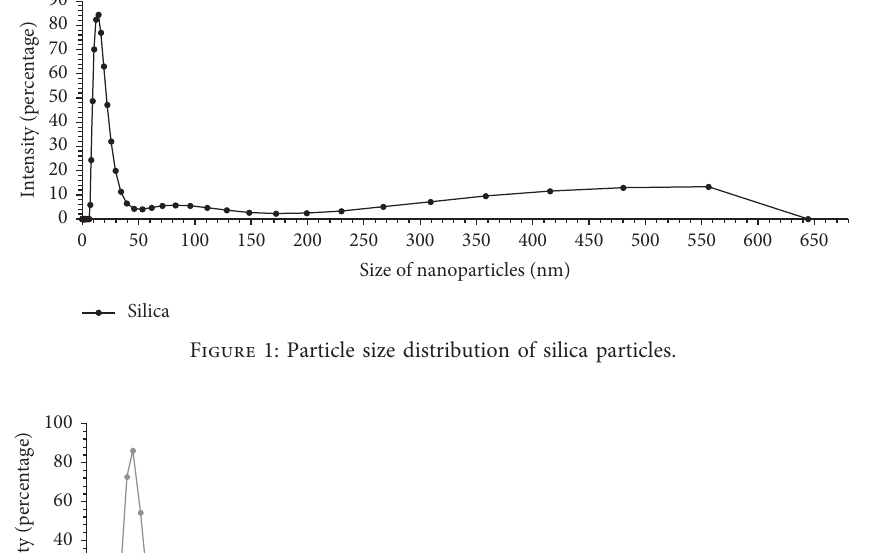
Figure 1: Particle size distribution of silica particles.